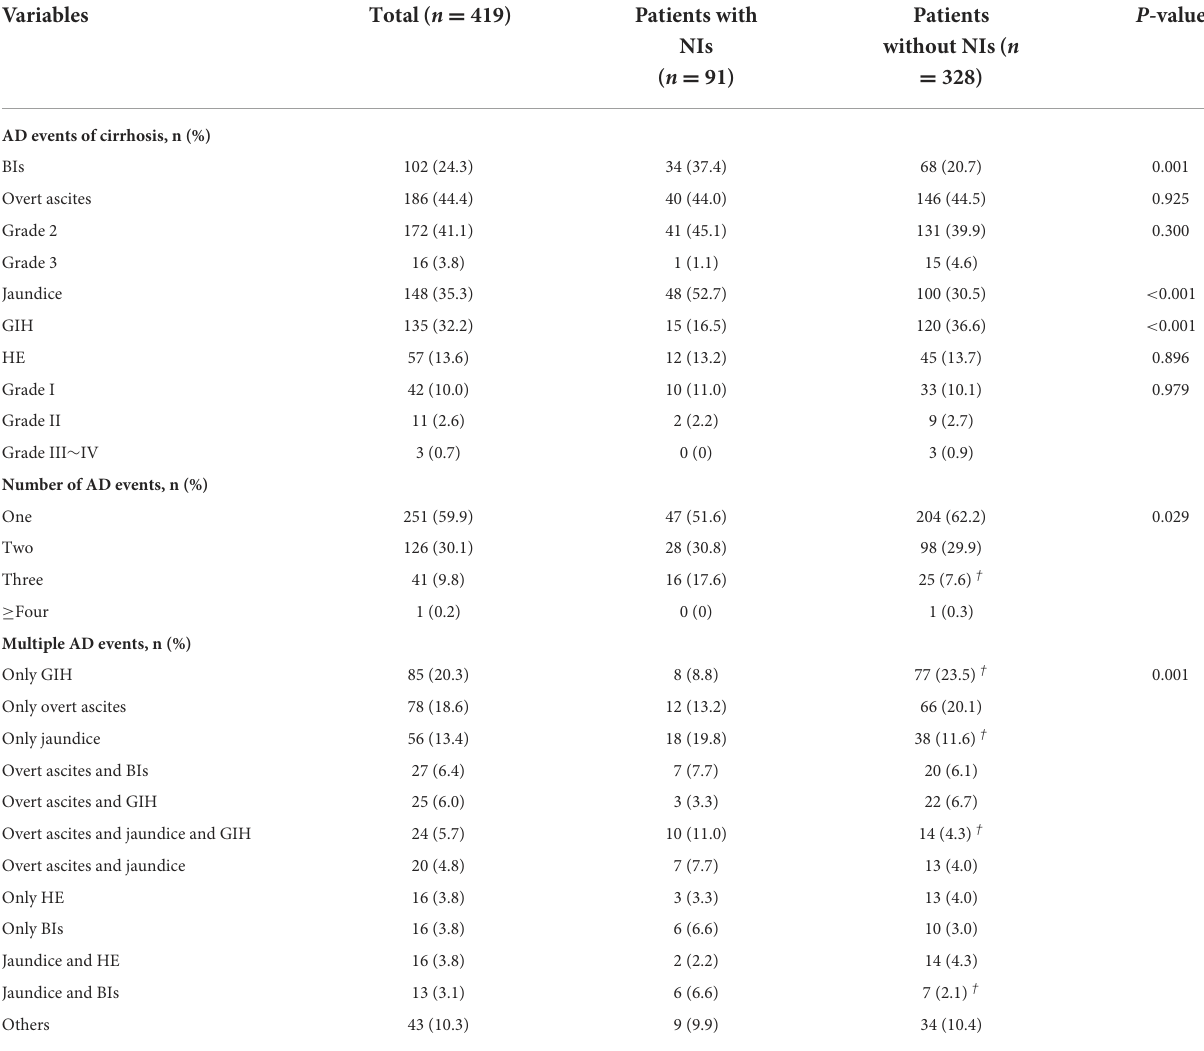
TABLE 2 Prevalence of AD events in enrolled patients with and without NIs. Variables Total ( n = 419) Patients with